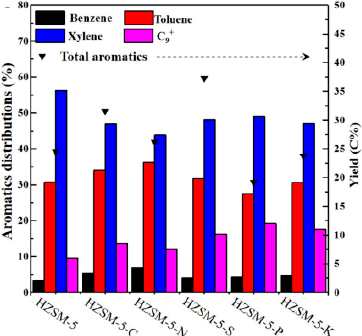
Figure 5. The yields and distribution of aromatics obtained by HZSM-5 zeolites synthesized with different additives.